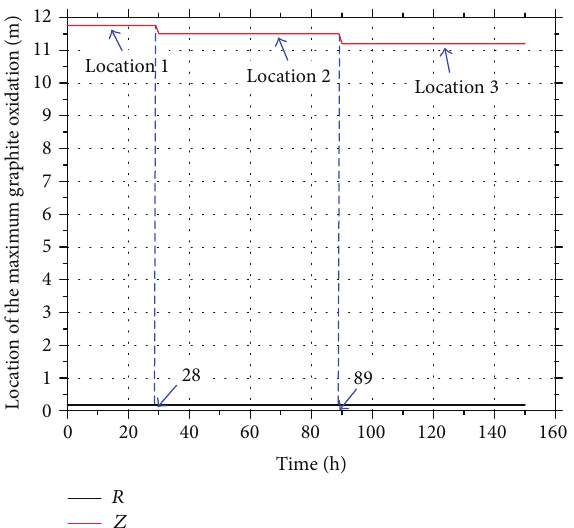
Figure 6: The location of the maximum local graphite oxidation of the bottom